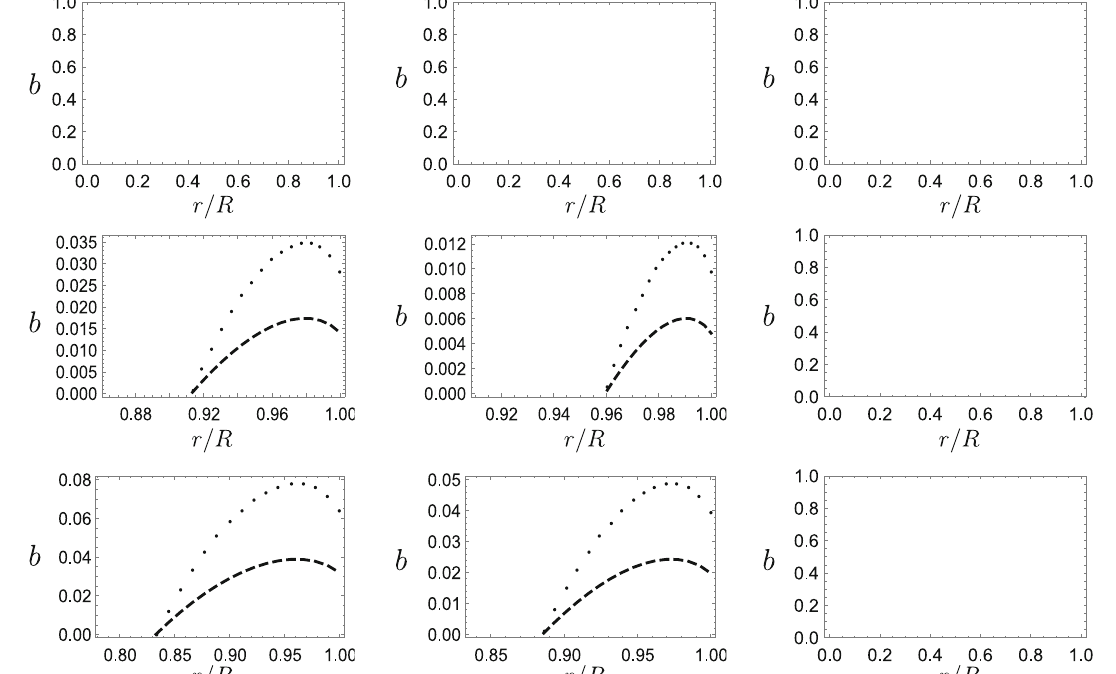
just the counter-rotating directions of the null geodesics (giving twice the values for the dashed curves). The first column is for θ = π/ 2, the second is for θ = π/ 4 and the last is for θ = 1 / 100. The first row is for j = 0 . 1, the second is for j = 0 . 4 and the last is for j = 0 . 7